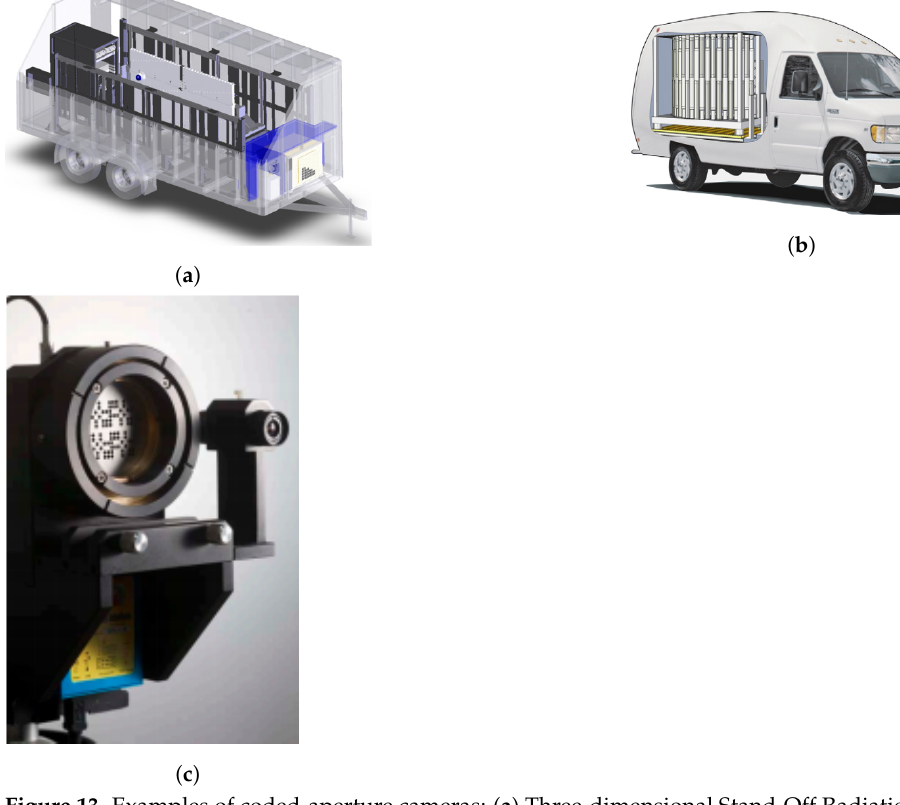
Figure 13. Examples of coded-aperture cameras: ( a ) Three-dimensional Stand-Off Radiation Detec- tion System (SORDS-3D). Reproduced, with permission, from Reference [179]; copyright Elsevier (2011). ( b ) Stand-Off Radiation Imaging System (SORIS). Reproduced, with permission, from Ref- erence [196]; copyright Elsevier (2011). ( c ) GAMPIX detector to be coupled in a multi-rotor UAV (MOBISIC project). ©2011 IEEE. Reprinted, with permission, from Reference